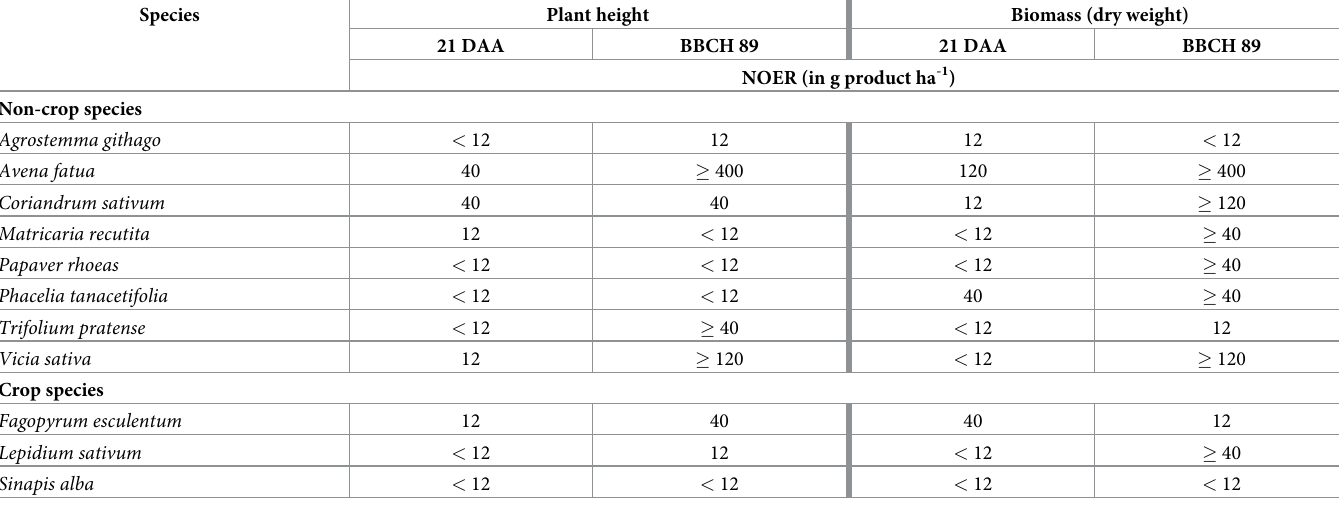
Table 5. NOER of plant species where height and biomass could be assessed during the vegetative (21 DAA) and generative (BBCH 89) growth stage, respectively. Species Plant